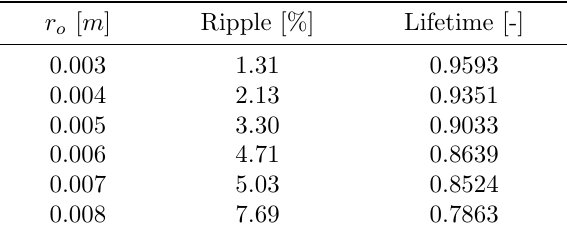
Table 13: Effect of piston orifice radius on ripples and gearbox